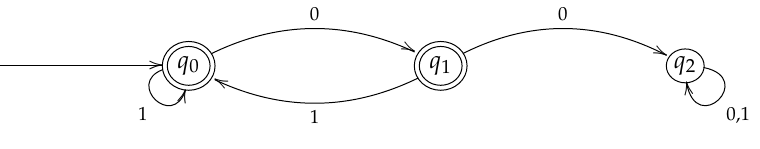
Figure 6. Example of an